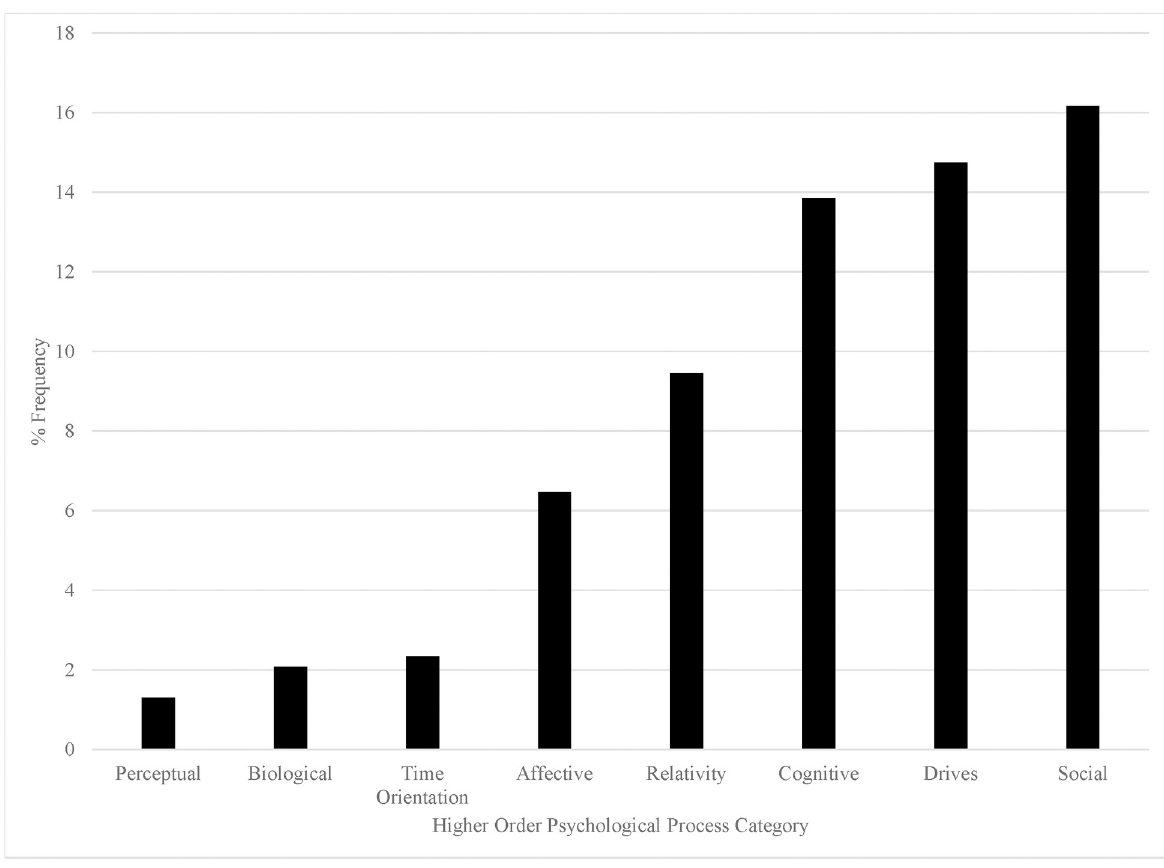
Fig 2. Percentage of word frequency for each of the LIWC higher order psychological process